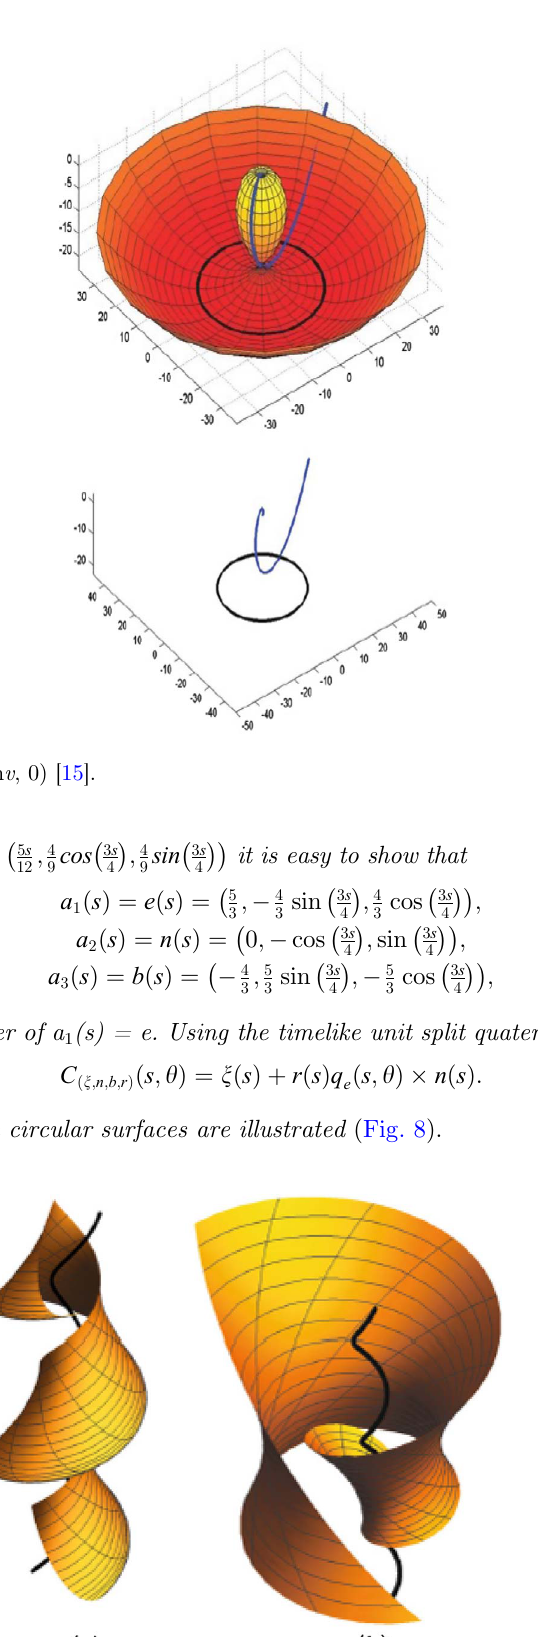
. (a) The circular surface C ( n , n , b ,1) , (b) the circular surface C 2